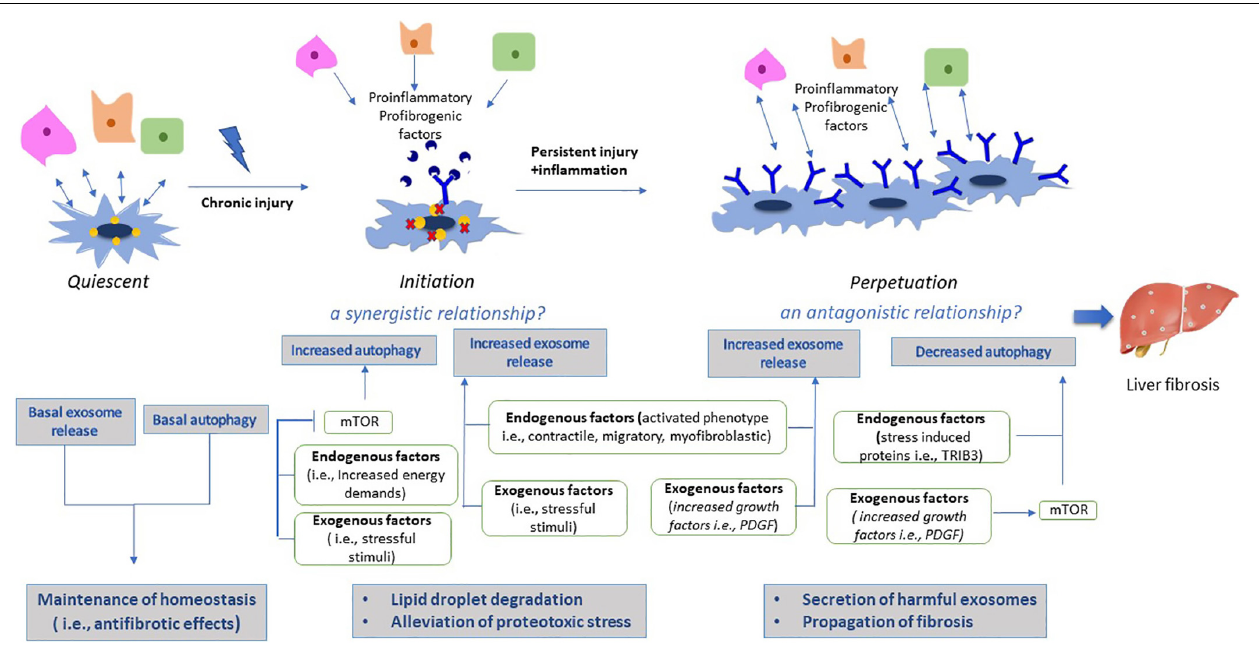
FIGURE 3 | Effects of autophagy and exosomes during HSC activation. Under normal conditions, qHSCs are characterized by basal autophagic levels and exosome release, indicative of their phenotypic characteristics as a resting, vitamin-A storing cell. Both autophagy and exosomal cargo contribute to maintenance of homeostasis by their antifibrotic effects. On the other hand, activation process is divided in two phases; initiation and perpetuation. During initiation phase, liver injury results in increased stress levels, thereby inducing autophagy by mTOR signaling pathway. However, aggregation of harmful substances derived from injured liver cells, exceeds autophagy capacity to degrade them, thus exosome secretion is synergistically upregulated as an alternative pathway to alleviate proteotoxic stress. In addition, activation of HSCs requires high energy levels, thus energy deprivation results in activation of lipophagy and lipid droplet degradation. During perpetuation phase, aHSCs have now been adapted to their new phenotype and micronenvironment, thus they no longer confront energy deprivation, resulting in decreased autophagic levels. Downregulation of autophagy has been potentially associated with induction of harmful secretion of exosomes from aHSCs, thus resulting in propagation of liver